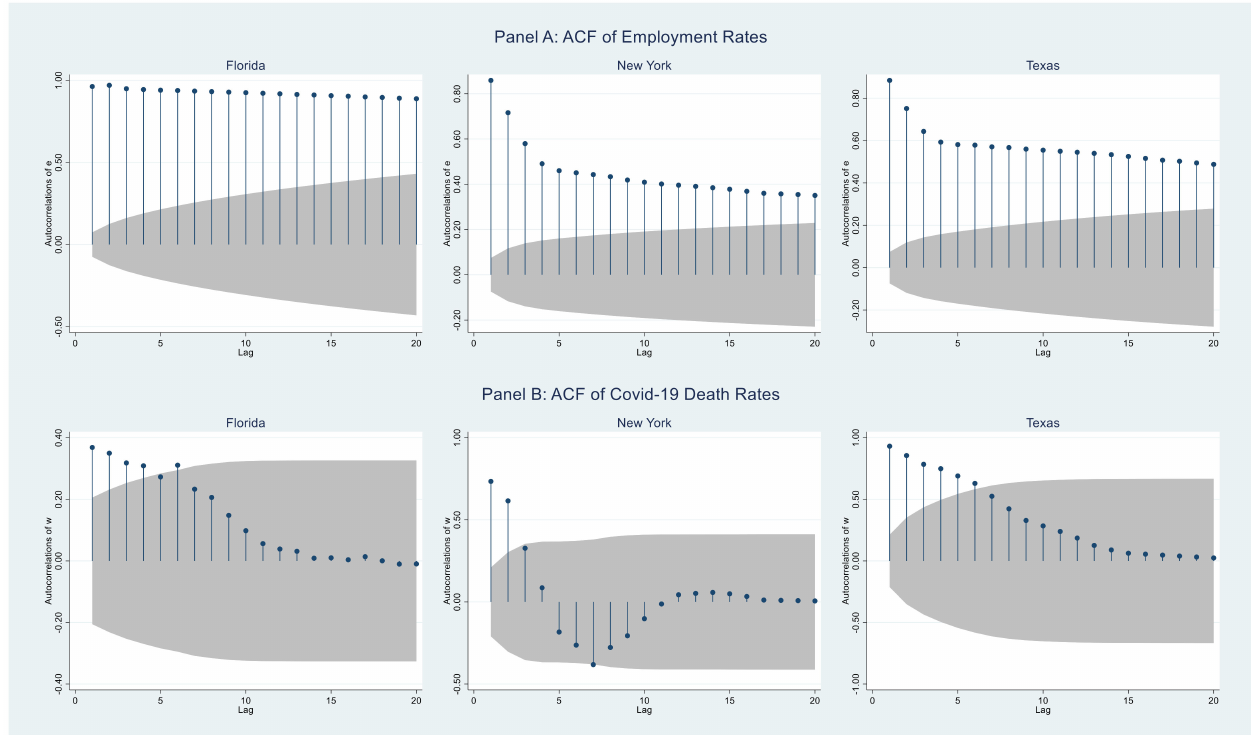
Figure 2. ACF plots for the employment and death rate series by state.